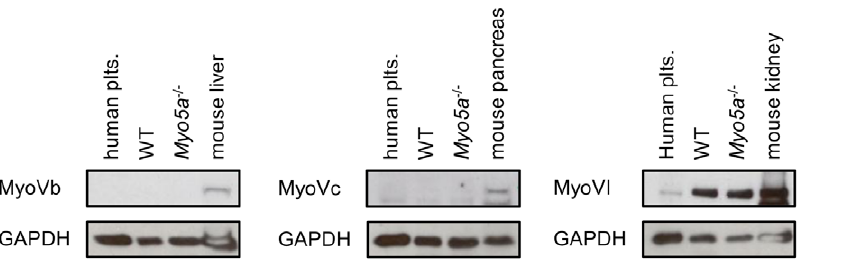
Figure 4. No enhanced expression of myosin Vb, Vc and VI in Myo5a 2 / 2 platelets. Immunoblots showing the expression of myosin Vb, Vc, and VI in lysates from human, wild-type mouse (WT) and Myo5a 2 / 2 mouse platelets. Lysates from mouse liver, pancreas or kidney were used as positive controls for myosin Vb, Vc, and VI, respectively. GAPDH served as loading control. Images shown are representative of three independent